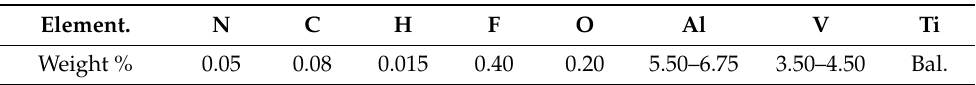
Table 1. Chemical composition of titanium alloy as mass percentage.